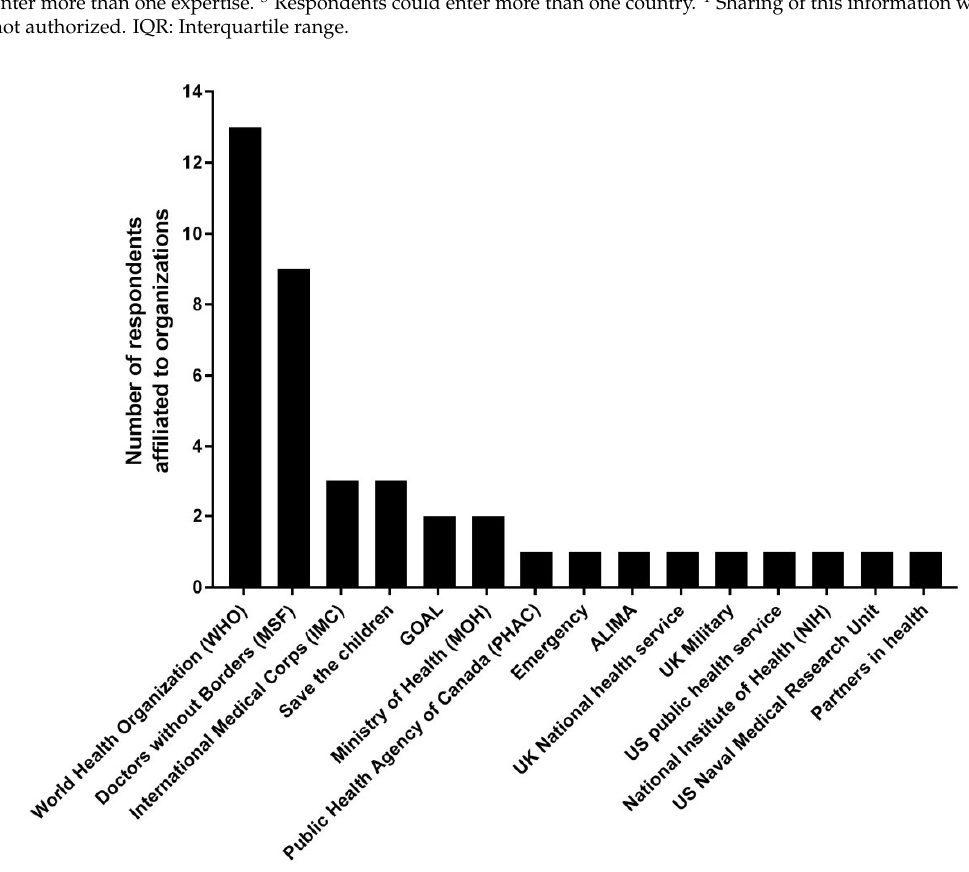
Figure 1. Professional affiliations reported by survey respondents.